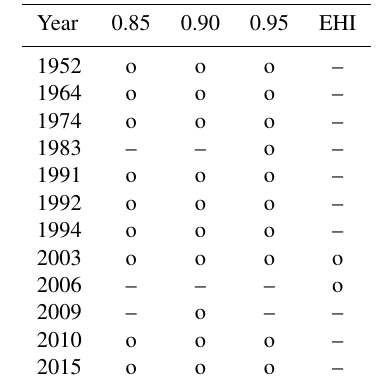
Table 9. As in Table 3 but for heatwaves in the GE region during JJA.